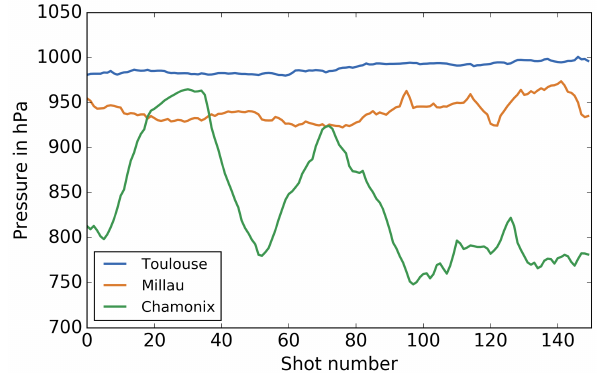
Figure 5. Surface pressure of the three scenes from the data sets. Toulouse, Millau and Chamonix present medium, high and very high variability, respectively (cf. Table 4).